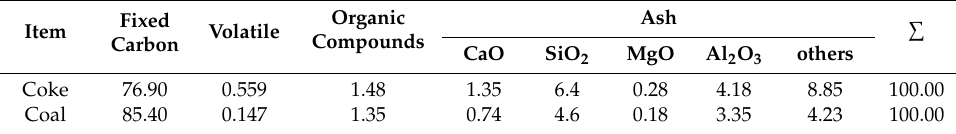
Table 2. Industrial analysis and chemical compositions of the fuel (wt